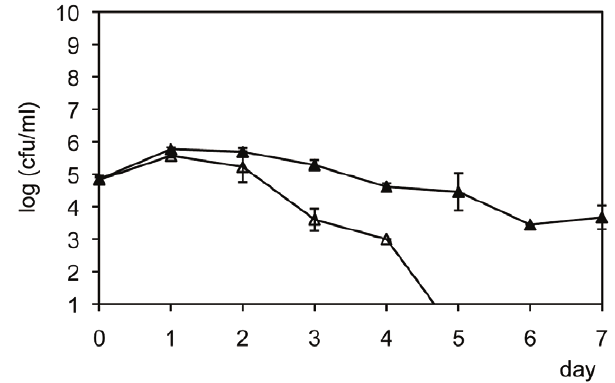
Figure 3. Uptake by Sulfitobacter sp. RO3 and Vibrioanguillarum of 14 C-excreted photosynthetic metabolites (EPM) produced by N. oculata cultures. Circles: Sulfitobacter sp. and triangles: V. anguillarum (Error bars=SD).